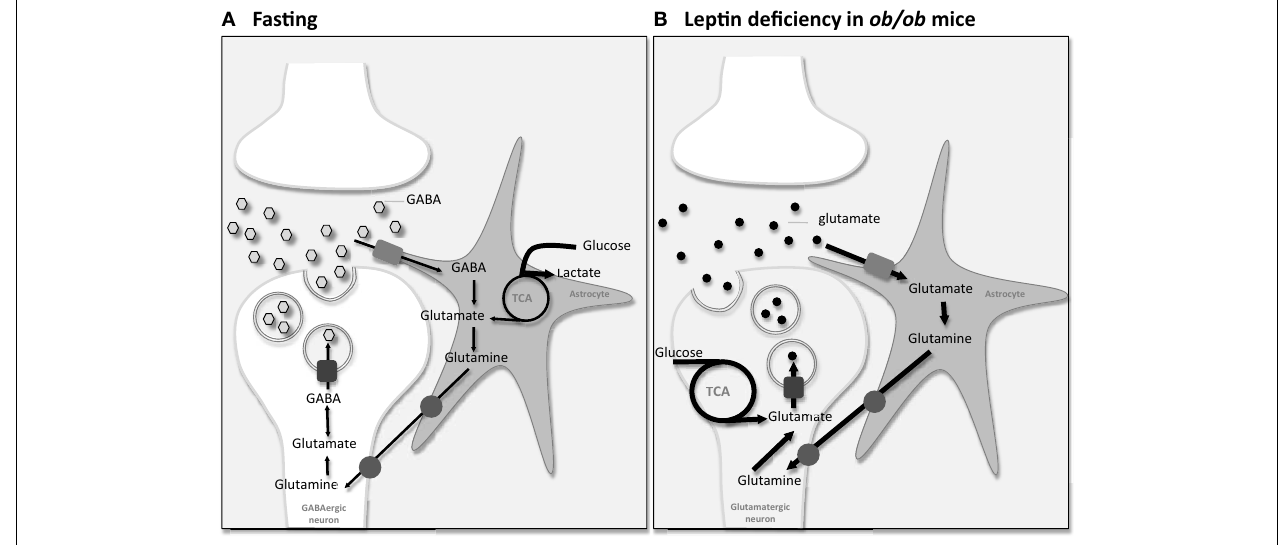
FIGURE 2 | Information on the integrated neuronal-astrocytic metabolic coupling mechanisms underlying appetite regulation can be investigated using [1- 13 C]glucose injection followed by analysis by 13 C High-Resolution MagicAngle Spinning (HR-MAS) Nuclear Magnetic Resonance (NMR) spectroscopy analysis of mice hypothalamus biopsies . (A) Fasting-induced changes:Violante et al. showed that increased neuronal firing in the hypothalamus triggered by fasting may stimulate the use of lactate as neuronal fuel leading to increased astrocytic glucose consumption and glycolysis (dark bold arrows). Moreover, fasted mice showed increased hypothalamic [2- 13 C]GABA content most probably attributable to the existence of